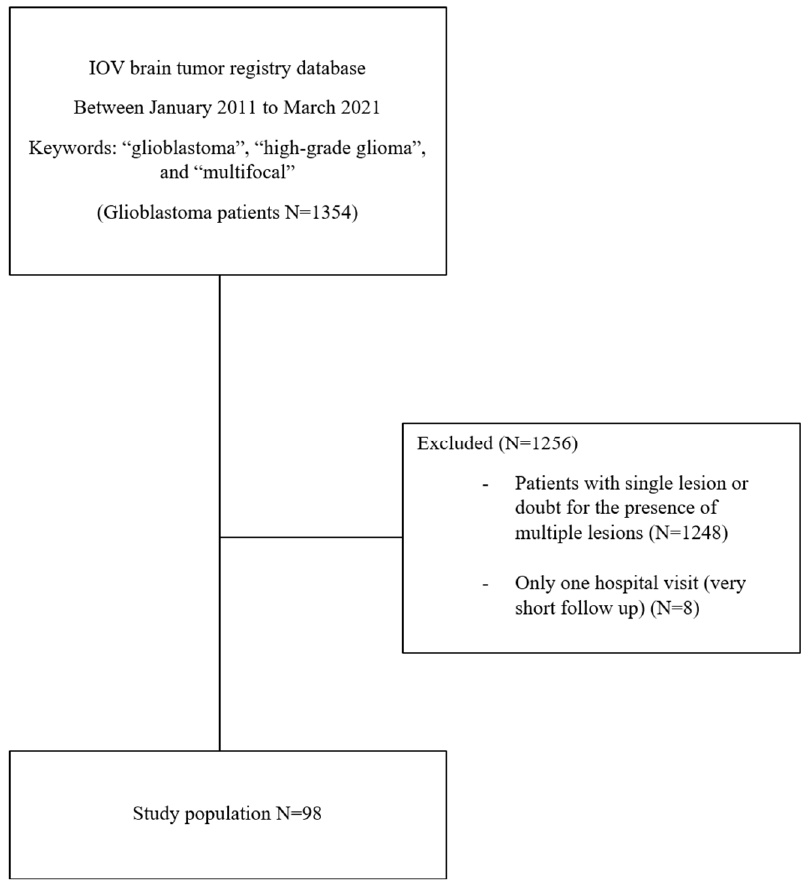
Figure 1. Summary of the patient selection